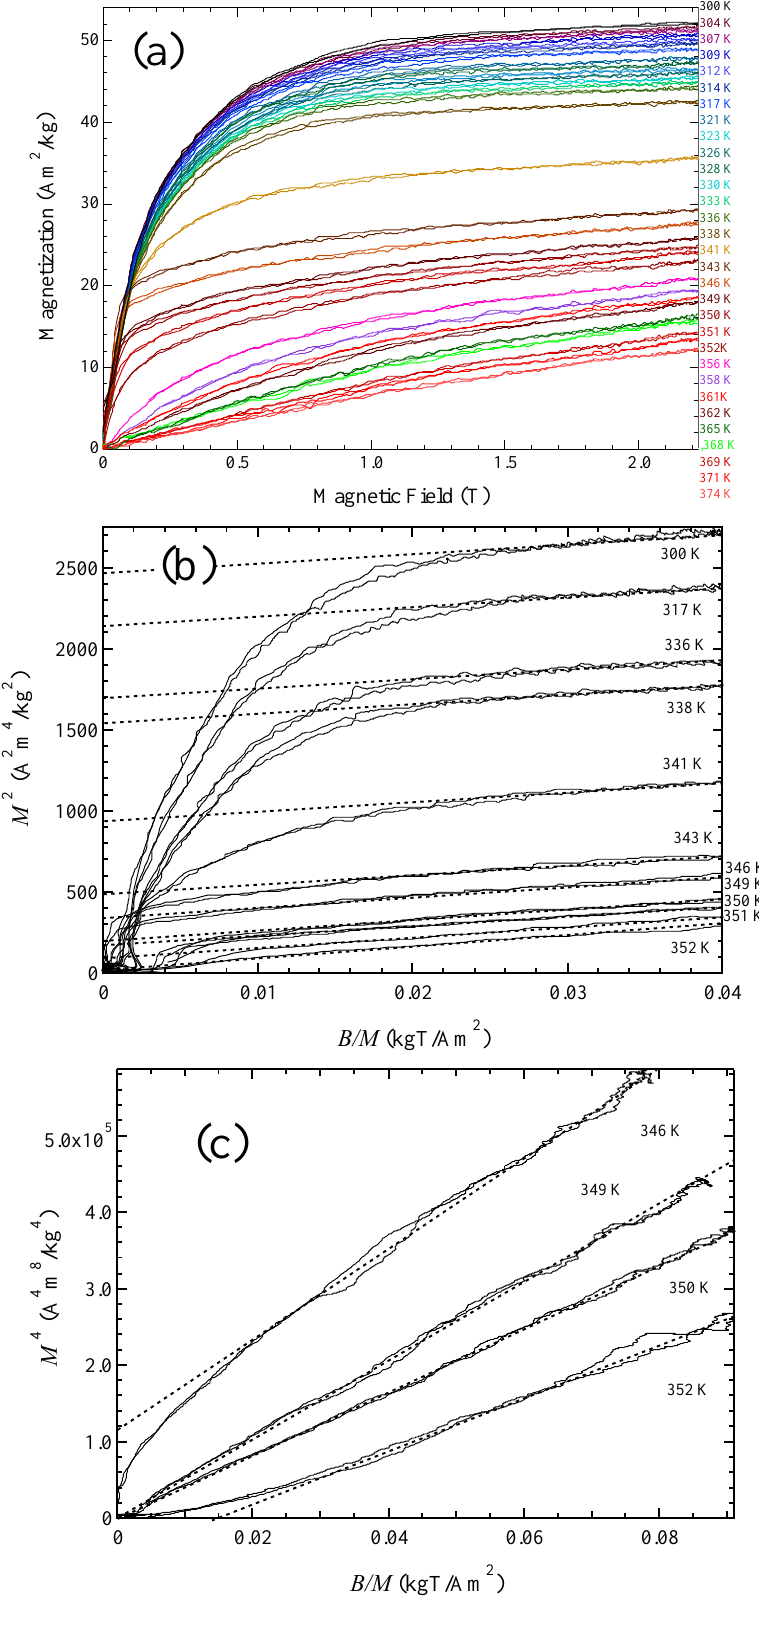
Figure 6. ( a ) Magnetization of Ni ( b ) Arrott plot of the magnetization of Ni lines; ( c ) M 4 vs. B/M plot for Ni